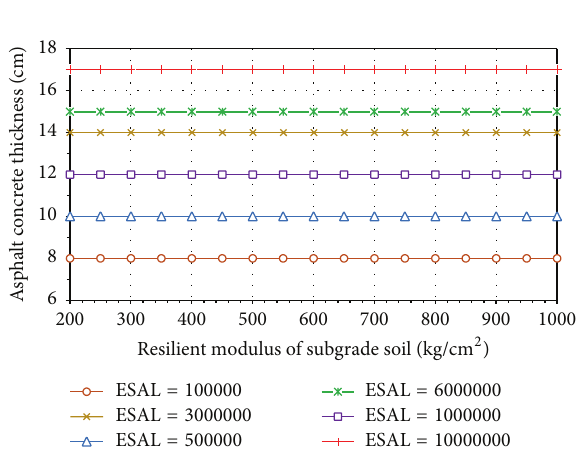
Figure 2: Optimal design thickness of asphalt concrete for sec- ondary rural roads.